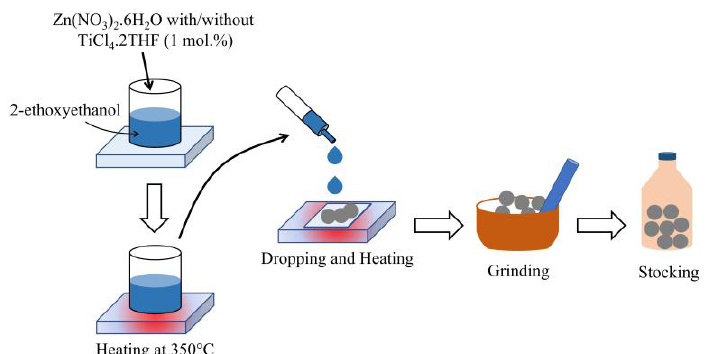
Figure 1. The illustrated flow diagrams of ZnO and Ti-ZnO NPs synthesized by rapid combustion. The synthesized combustion products of ZnO and Ti-ZnO were characterized using several methods. The morphology was observed using a scanning electron microscope (SEM, JSM-6610 LV, JOEL) equipped with an energy dispersive X-ray spectrometer (EDS, INCAx-act, OXFORD) for elemental detection. The high-resolution morphology and selected area electron diffraction (SAED) were investigated using a transmission electron microscope (TEM, TECNAI G 2 20 S-TWIN, FEI). The crystal structure was determined by X-ray diffraction (XRD) patterns recorded on an X-ray diffractometer (D8 Advance, Bruker). The crystal sizes of ZnO and Ti-ZnO were calculated using the Debye–Scherrer equation (Equation (1)) [14,19]: where k and λ are the shape factor of the XRD measurement (0.89) and the wavelength of the X-ray source (1.5406 Å), respectively. The β and θ are the full width at half maximum (FWHM) and the diffraction angle for each plane, respectively. A surface functional group analysis was conducted using Fourier transform infrared spectroscopy (FTIR, Spectrum Two, PerkinElmer). A pore analysis was performed by physisorption of N 2 adsorption– desorption at 77 K using a Tristar II3020, Micrometrics. The adsorption–desorption isotherm was plotted to identify the pore structure. The pore width and specific surface area were analyzed using the Barrett–Joyner–Halenda (BJH) and Brunauer–Emmett–Teller (BET) methods. The band gap energy (E g ) was investigated from the diffuse reflectance absorption spectra for ZnO and Ti-ZnO using an ultraviolet-visible-near infrared (UV – Vis-NIR) spectrophotometer (UV-3101 PC, Shimadzu). The recorded spectra were then analyzed according to the Tauc’s relation (Eq uation (2)) [20 – 22]: